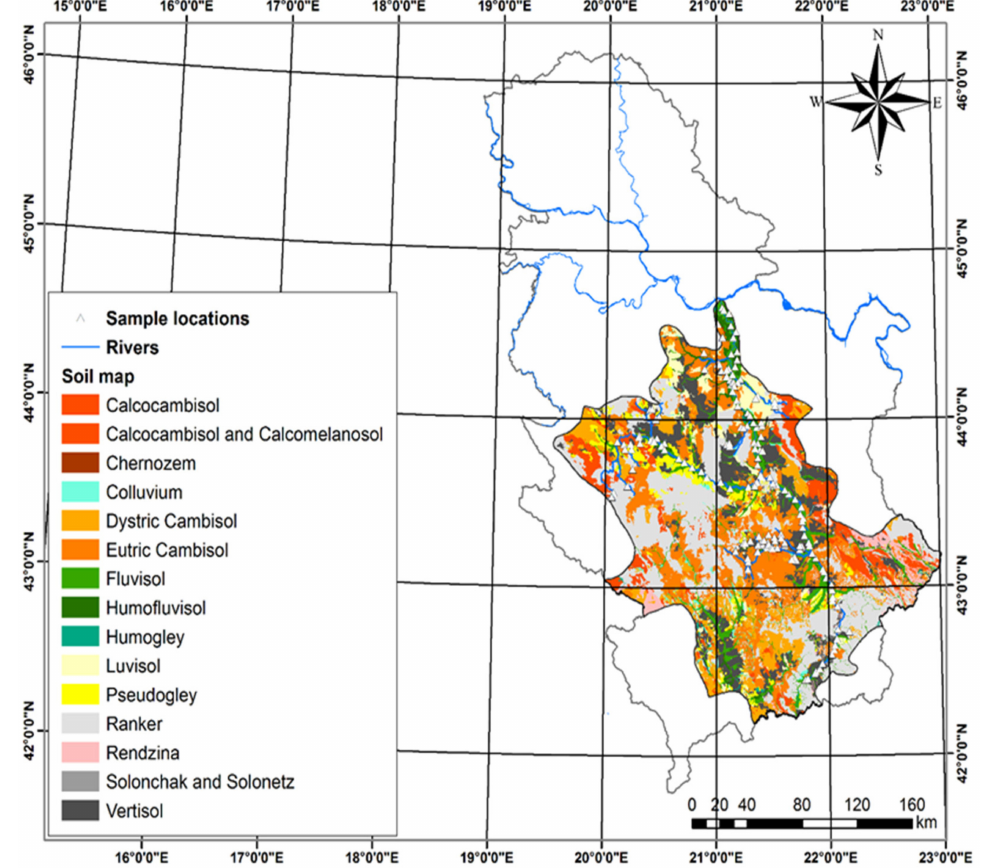
Figure 3. Pedological map of the study